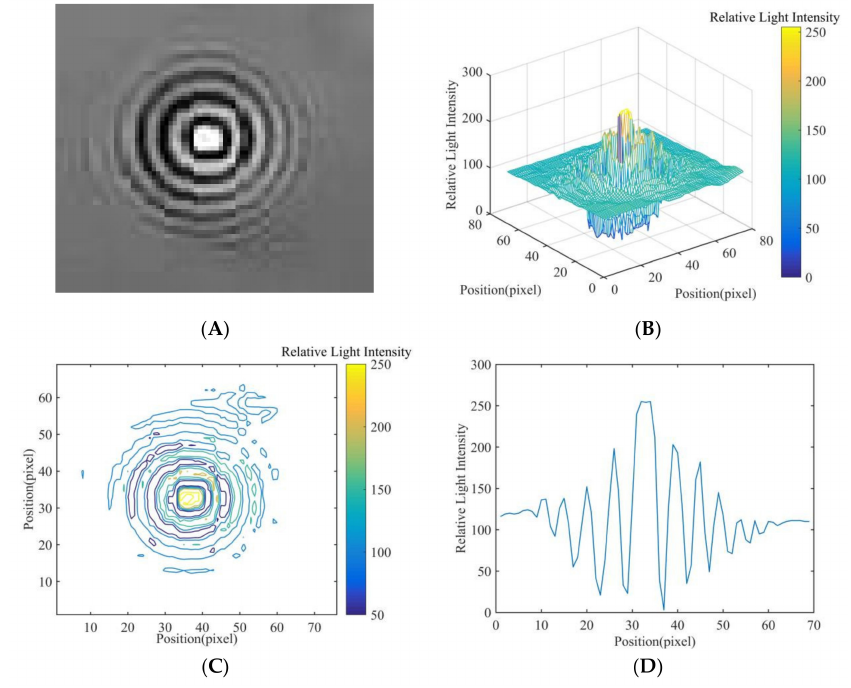
Figure 5. Results of P. cubensis spore fingerprint image processing, ( A ) diffraction image, ( B ) three- dimensional relative light intensity distribution, ( C ) two-dimensional relative light intensity distribu- tion, and ( D ) relative light intensity distribution value.